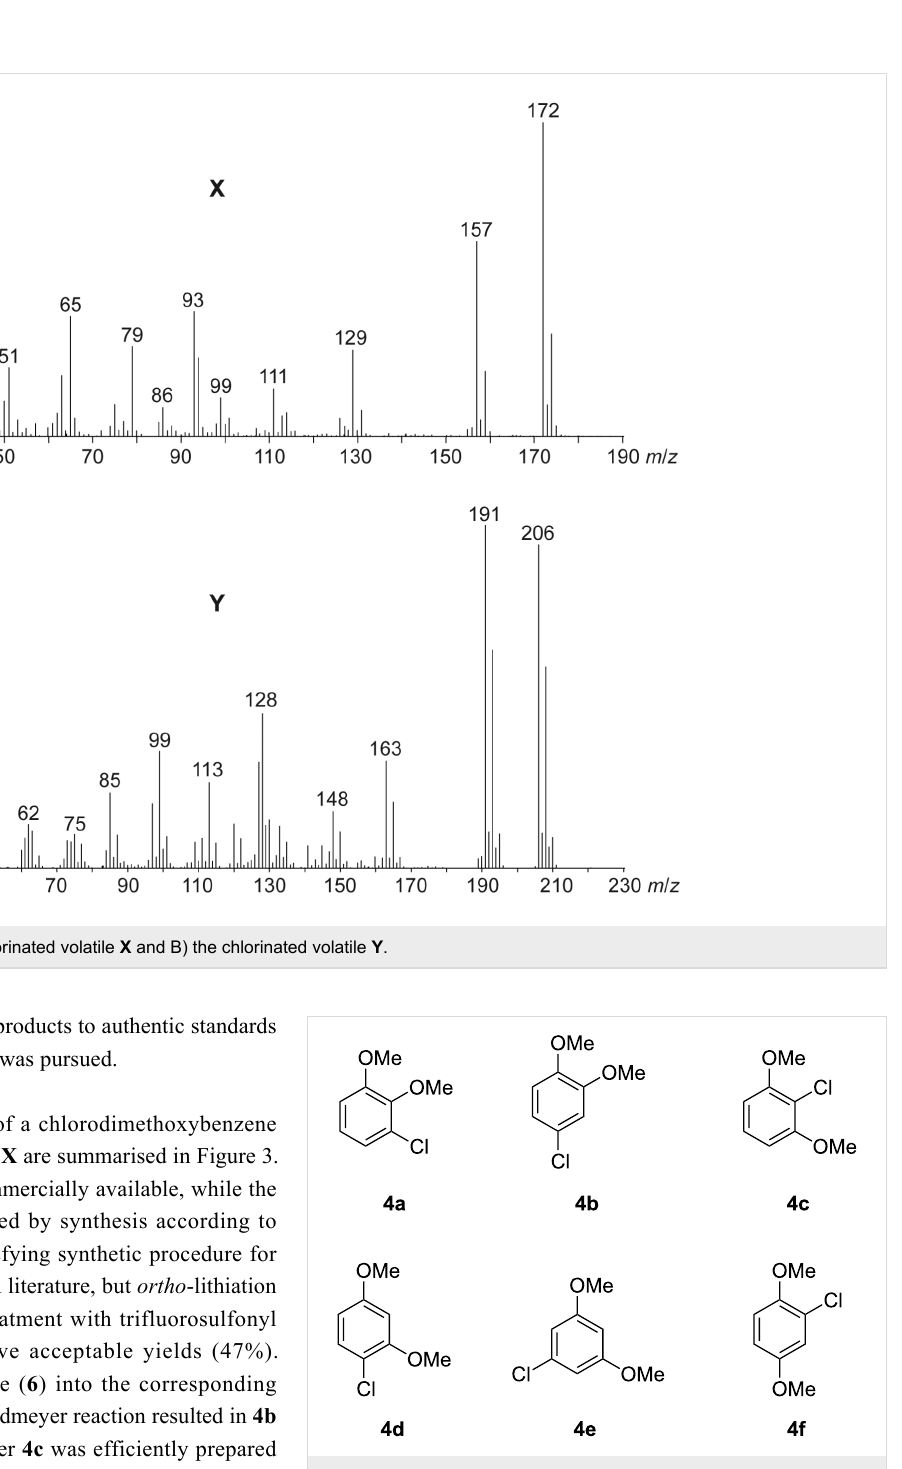
Figure 3: Constitutional isomers of chlorodimethoxybenzene as candi- date structures for X .